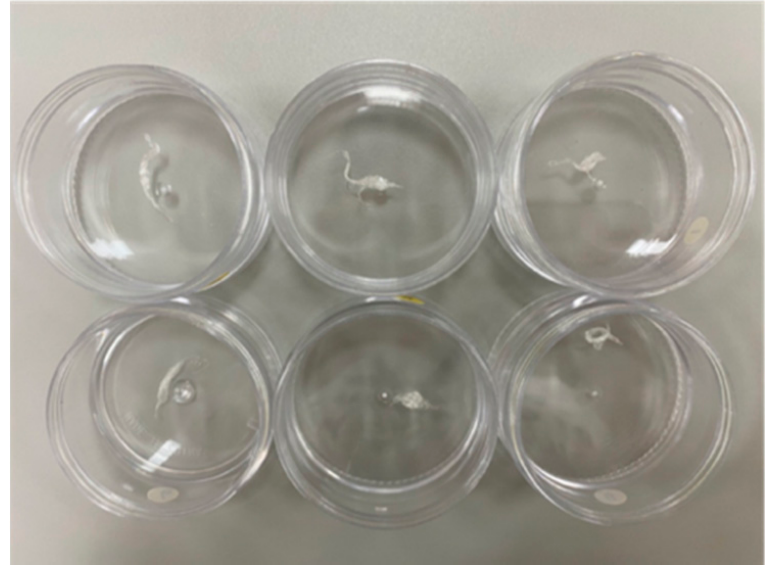
Figure 1. Prepared polymiade 66 (PA66) microfibre samples.